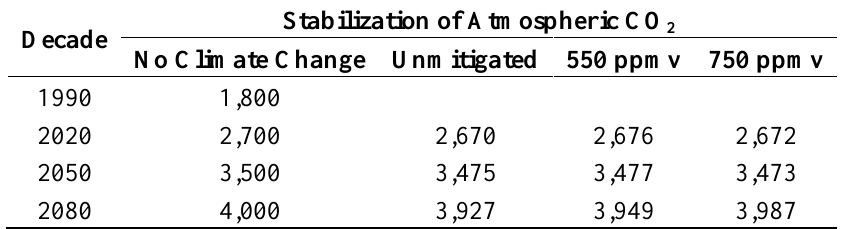
Table 3. Estimates of CO fertilization effect on average annual global cereal production 2 (10 6 Mg) with and without the projected climate change (adapted from